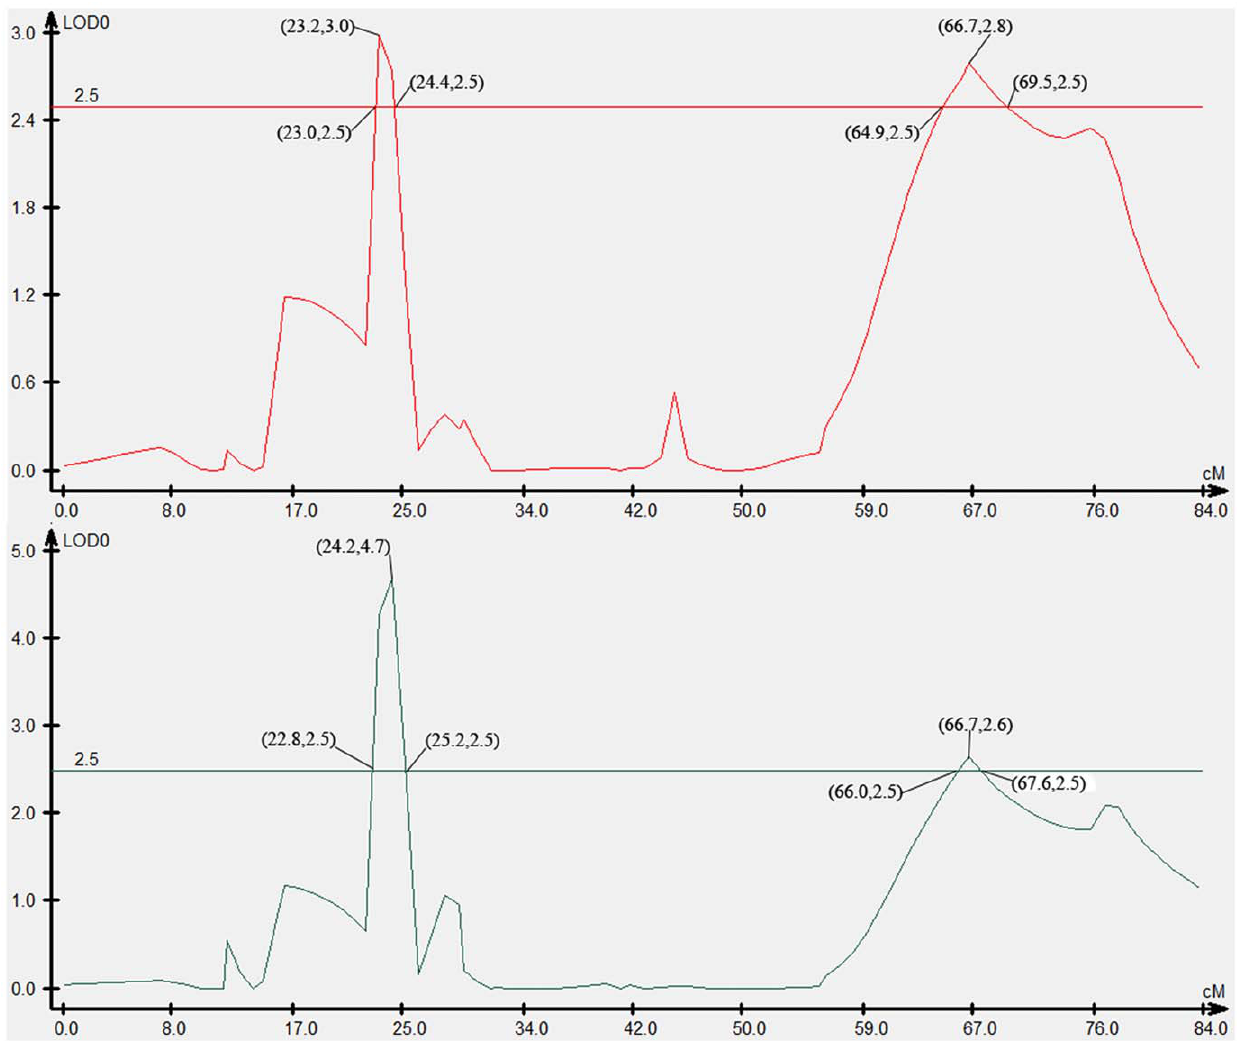
Figure 5. LOD curve graph of four growth-related QTLs. Abscissa indicates the relative position on the linkage groups, vertical coordinates indicates the value of LOD; the figure in ‘‘()’’ represents (position, value of LOD).